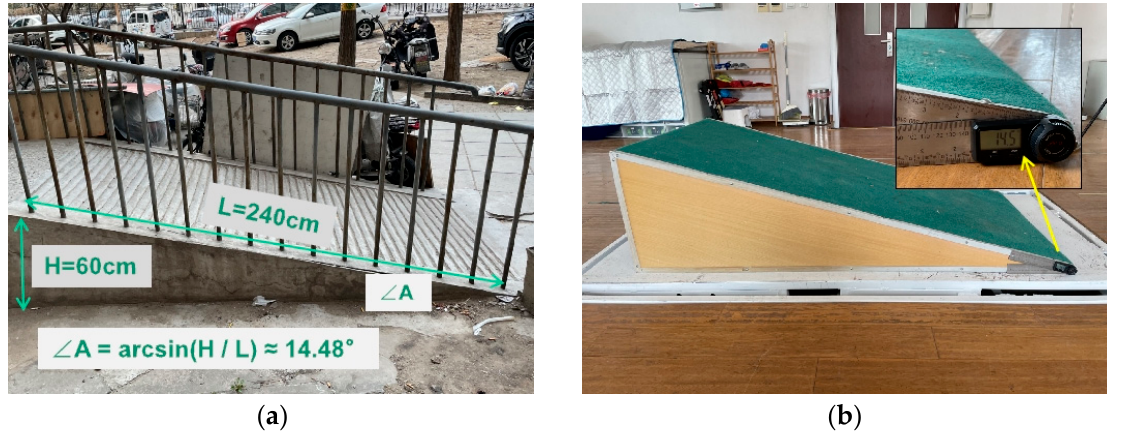
Figure 2. The degree of slope in the barrier-free environment: ( a ) measured in an old community, and ( b ) simulated in the experimental environment.